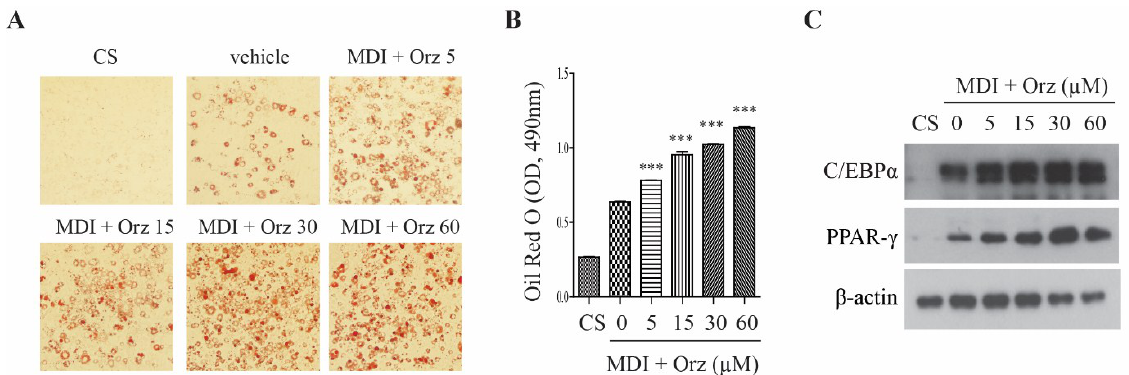
Figure 1. Effects of γ-oryzanol (Orz) on adipocyte differentiation in 3T3-L1 adipocyte cells. 3T3-L1 cells were treated with Orz during adipocyte differentiation for 8 days. ( A ) Lipid accumulation was visualized using Oil Red O staining. ( B ) Quantification of the relative intensity of the Oil Red O, measured at a wavelength of 490 nm. ( C ) Protein expression was analyzed using immunoblot with C/EBPα and PPAR-γ antibodies. Values are means ± SEM, n = 3, * p < 0.05; ** p < 0.01; *** p < 0.001 compared to vehicle. PPAR-γ, peroxisome proliferator-activated receptor gamma; C/EBPα, CCAAT/enhanced binding protein alpha. CS, normal medium with calf serum. MDI, medium containing 0.5 mM of 3-IBMX, 1 μM of dexamethasone and 1 µg/mL of